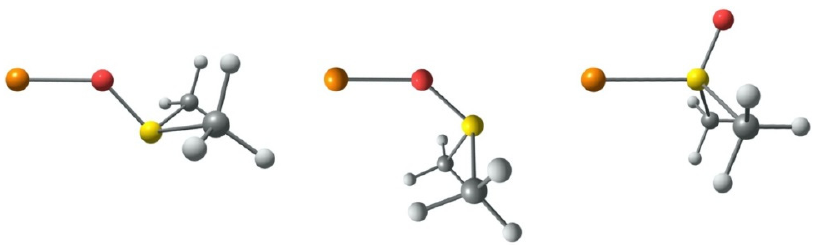
Figure 1. Fully optimized geometries of Cu I DMSO- κ O α ( left ), Cu I DMSO- κ O β ( middle ), Cu I DMSO- κ S ( right ); level of theory: (PCM-)M06/6-311+G(d,p). Color legend: copper (orange), oxygen (red), sulfur (yellow), carbon (grey), hydrogen (light grey).